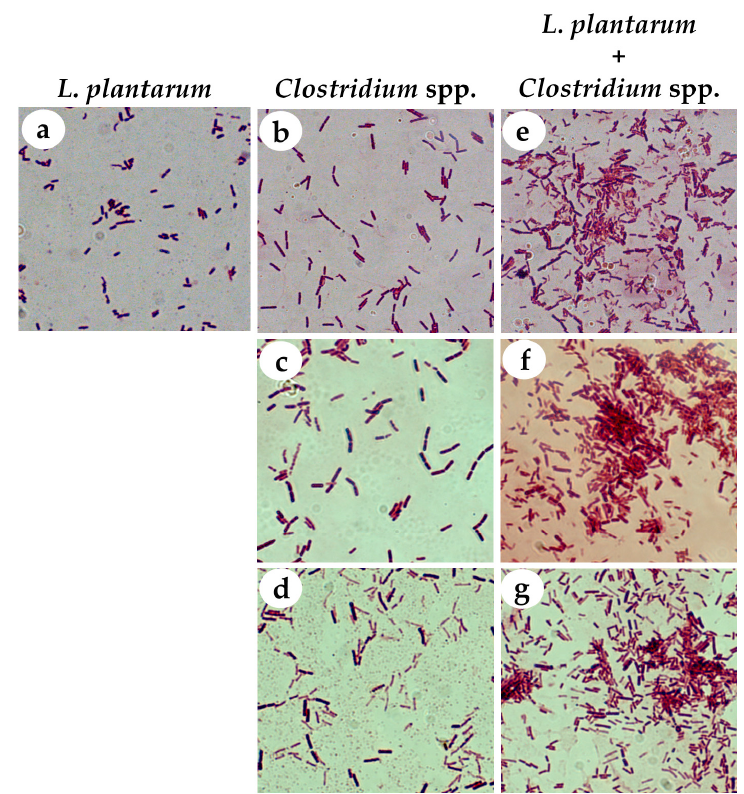
Figure 2. Gram staining of bacterial isolates before ( a–d ) and after ( e–g ) the coaggregation assays of L. plantarum ATCC 8014 with the three species of Clostridium. ( a ) L. plantarum , ( b ) C. butyricum , ( c ) C. difficile, and ( d ) C. perfringens controls. Coaggregation of L. plantarum and ( e ) C. butyricum , ( f ) C. difficile, or ( g ) C. perfringens . Formation of bacterial aggregates were observed after mixing L. plantarum with each Clostridium strain. Gram stained slides were visualized by light microscopy under a 100× oil immersion objective.